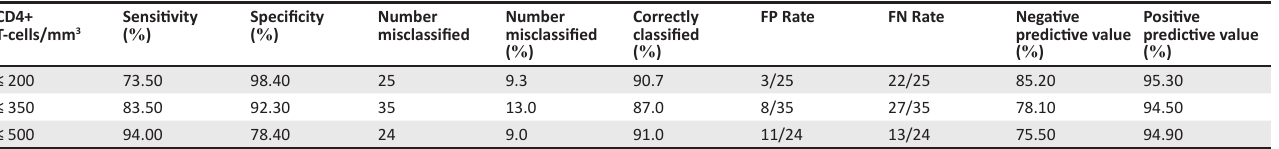
TABLE 4: Performance of PIMA TM analysers compared to National Health Laboratory Services at different CD4+ T-cell thresholds. CD4+ Sensitivity T-cells/mm 3 ( %